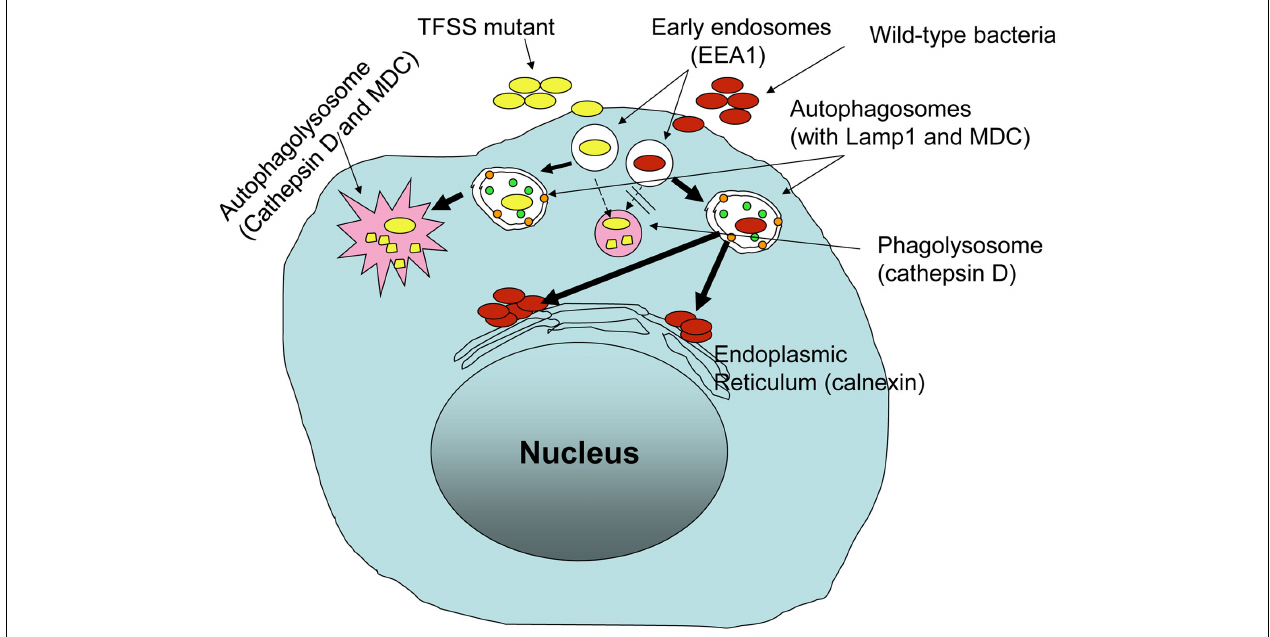
FIGURE 2 | Burkholderia cenocepacia PtwT4SS is required for subversion of endosomal pathway in host innate immune cells.